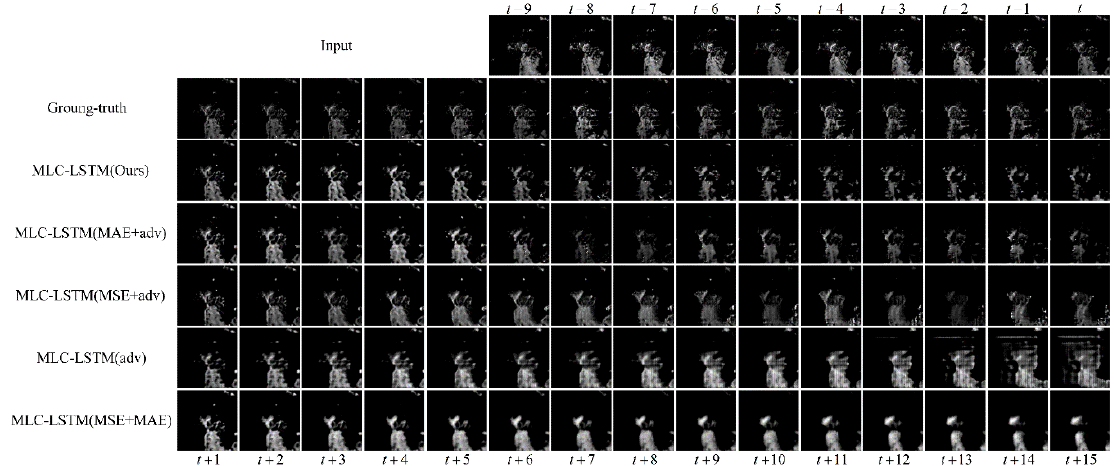
Figure 7. The extrapolation results for echo at Hangzhou, China, 8 August 2016, 23:07 UTC. The last five rows show the results obtained by MLC-LSTM trained with different loss schemes,